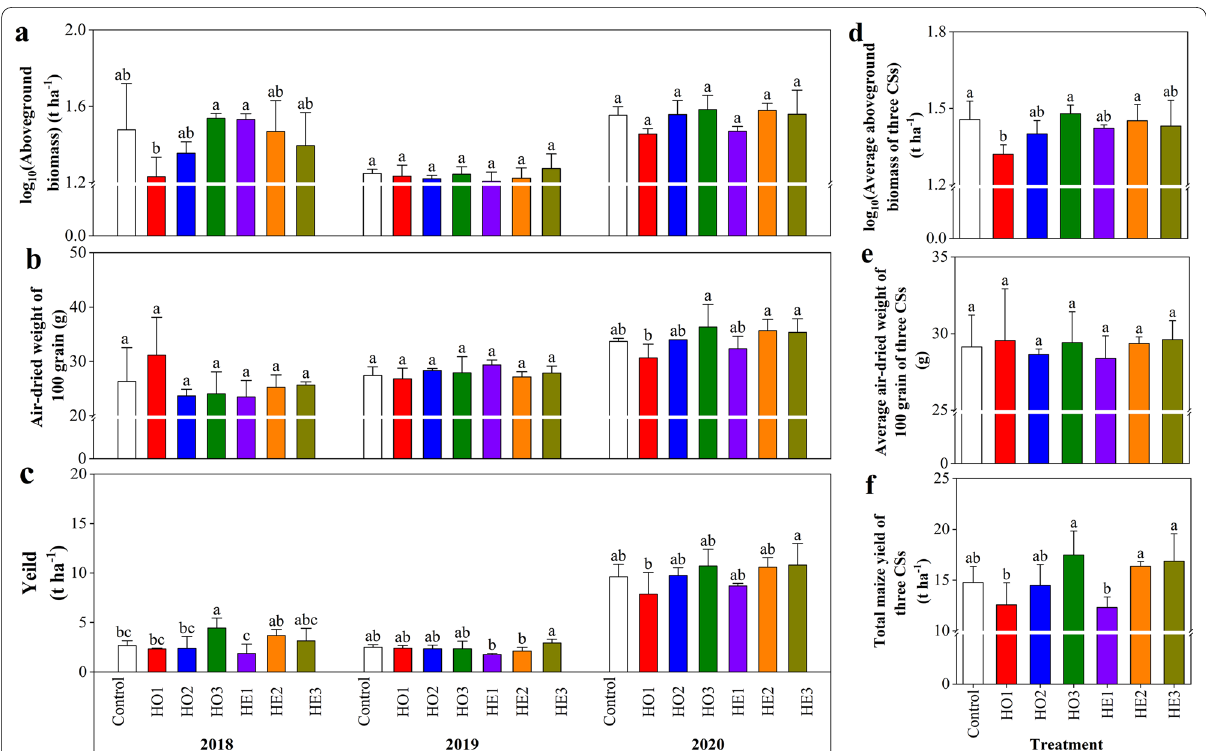
Fig. 6 Crop productivity index as affected by biochar application methods and amount. a Aboveground biomass of crops in 2018–2020. b Air-dried weight of 100 grain of crops in 2018–2020. c The yield of crops in 2018–2020. d Average aboveground biomass of three continuous cropping seasons (CSs). e Average air-dried weight of 100 grain of three CSs. f The total yield of three CSs. HO, homogeneous application; HE, heterogeneous application; 1, 2 and 3, biochar application was 10, 20 and 40 t ha − 1 , respectively, in both HO and HE treatments, Control, biochar application was 0. The same lowcase letter over each bar in the same cropping stage represents no significant difference ( P > 0.05) between